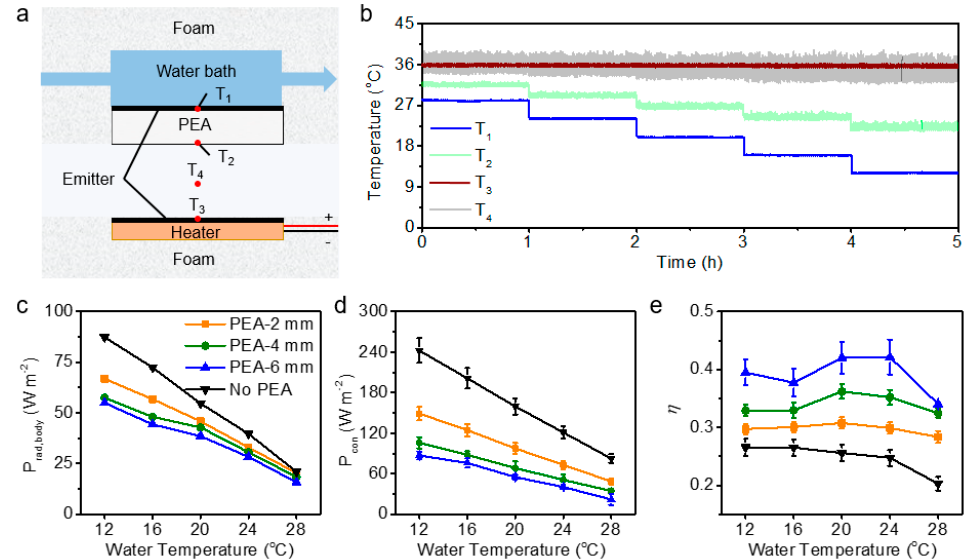
Figure 4. Heat transfer performance of the PEA samples. ( a ) Schematic of the experimental setup. ( b ) Temperatures recordings of the 2 mm thick PEA top surface (green line, T 2 ), the heater (red line, T 3 ), and ambient (gray line, T 4 ) in different water bath temperatures (blue line, T 1 ). ( c , d ) The radiative power from the heater ( c ) and conduction power from the environment ( d ) to the water bath at different temperatures with different thickness PEA samples. ( e ) The ratio ( η ) of radiative power to conduction power with different water bath temperatures.